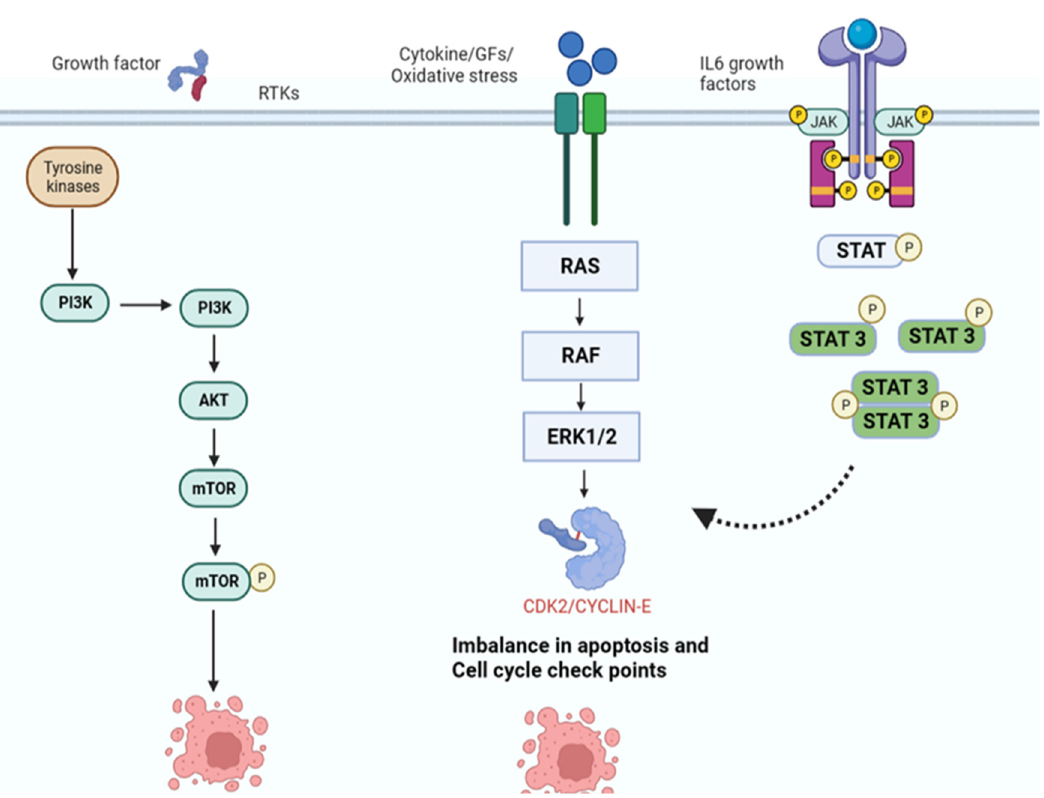
Figure 4. Different signaling pathways targeted by the phytochemicals responsible for the onset of cancer and cancer proliferation, metastasis, and invasion.